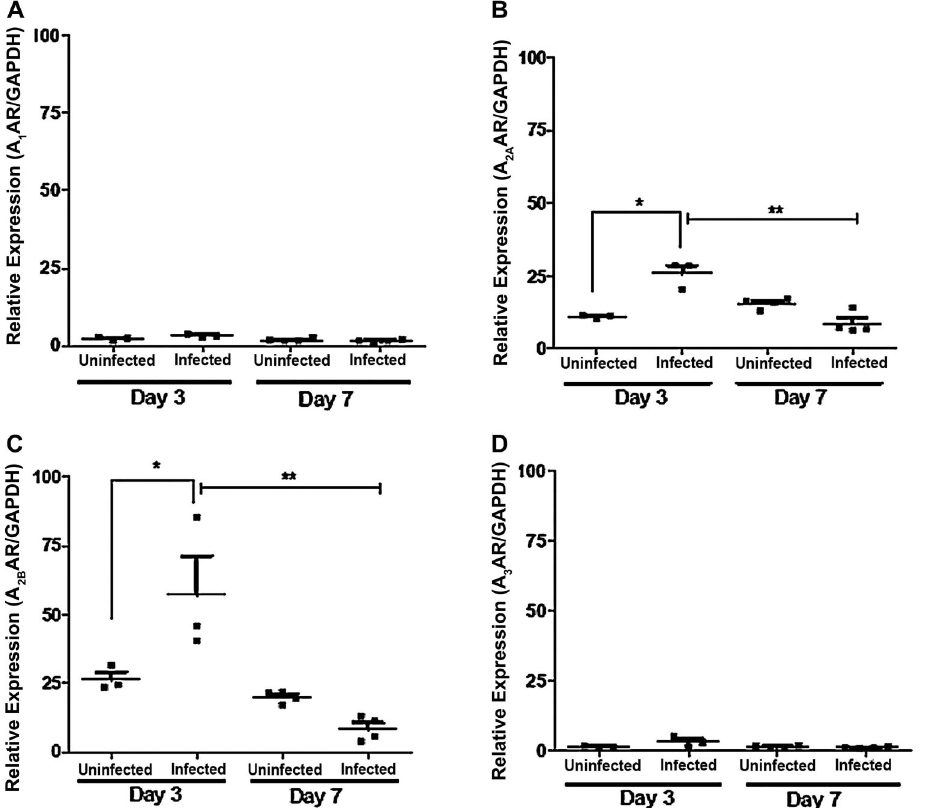
Figure 5 . Effects of C. dif fi cile infection on the AR in cecal tissue. Mice (n=3 to 4/group) were infected with C. dif fi cile (10 5 CFU, colony forming units) and were sacri fi ced at either 3 or 7 days after the infection. mRNA was extracted from cecal tissues for A 1 AR ( A ), A 2A AR ( B ), A 2B AR ( C ), and A 3 AR ( D ) analysis by qPCR. *P o 0.05 compared with uninfected mice; **P o 0.05 compared with infected mice at day 3 (one-way ANOVA with Bonferroni post-test). Vertical lines indicate mean ±